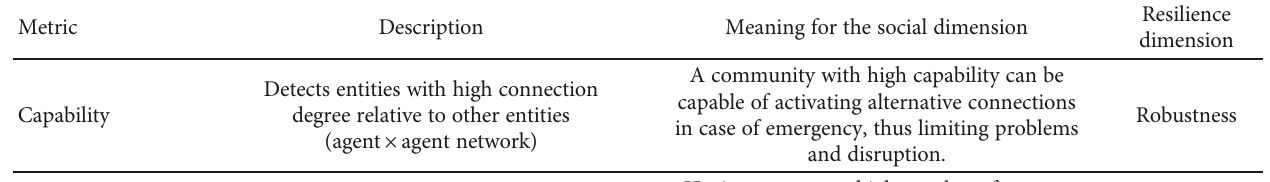
Table 5: GT measures for the analysis of the social dimension of resilience.